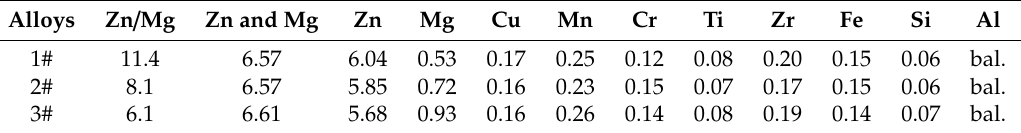
Table 1. Chemical composition of Al-Zn-Mg alloys with di ff erent Zn / Mg ratios (wt%).